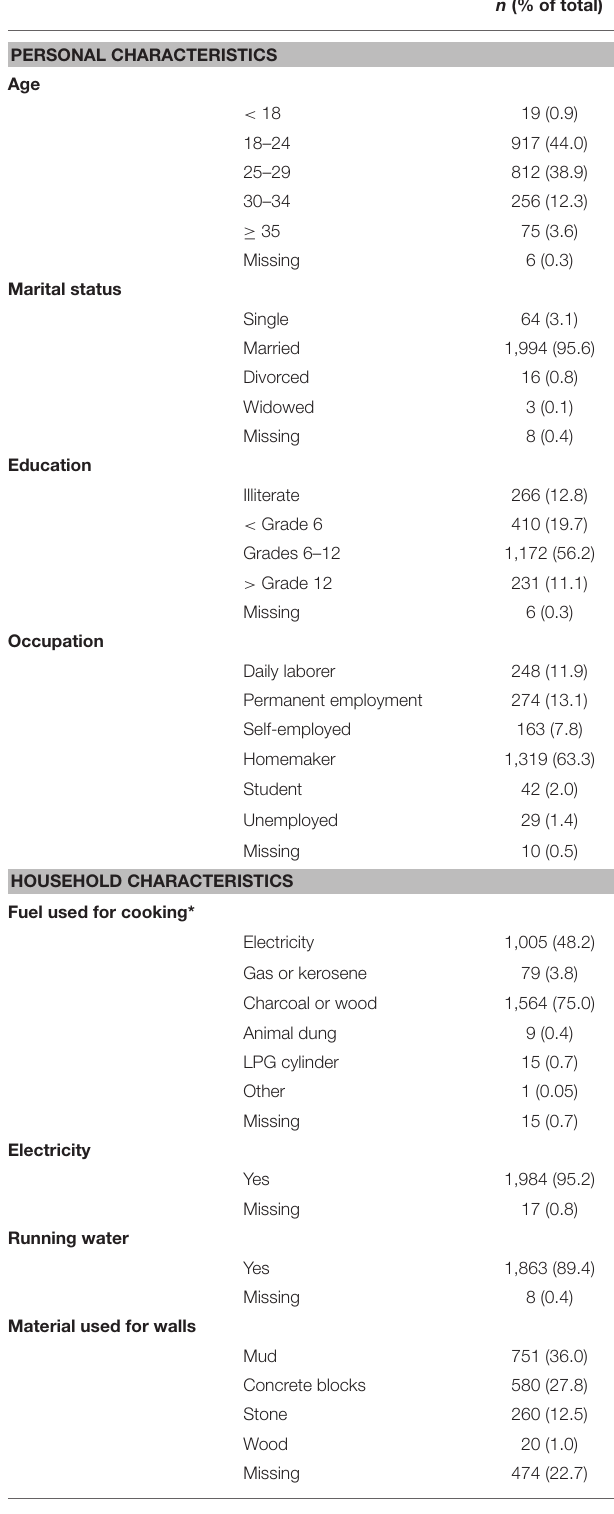
TABLE 1 | Demographic information on the women comprising the Adama mother and child cohort ( n = 2,085) including both household and residential